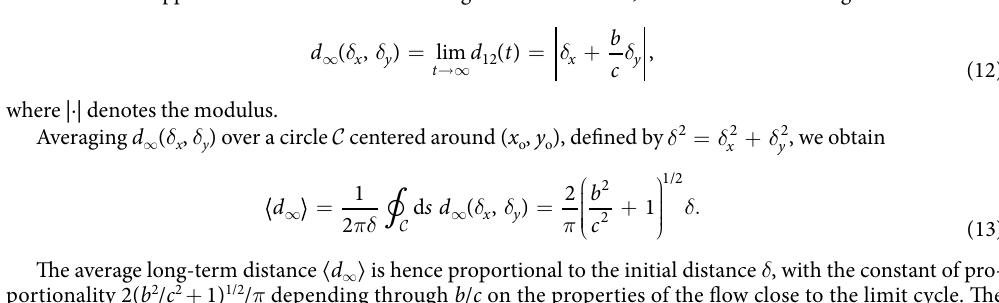
2 1/2 the initial Euclidean distance between